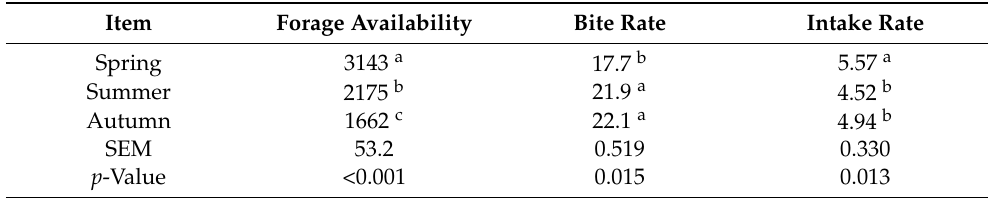
Table 1. Seasonal variation in forage availability (kg DM/ha), bite rate (bites/min), and intake rate (g DM/min) of goats grazing in a Mediterranean forest rangeland of northern Morocco. Item Forage Availability